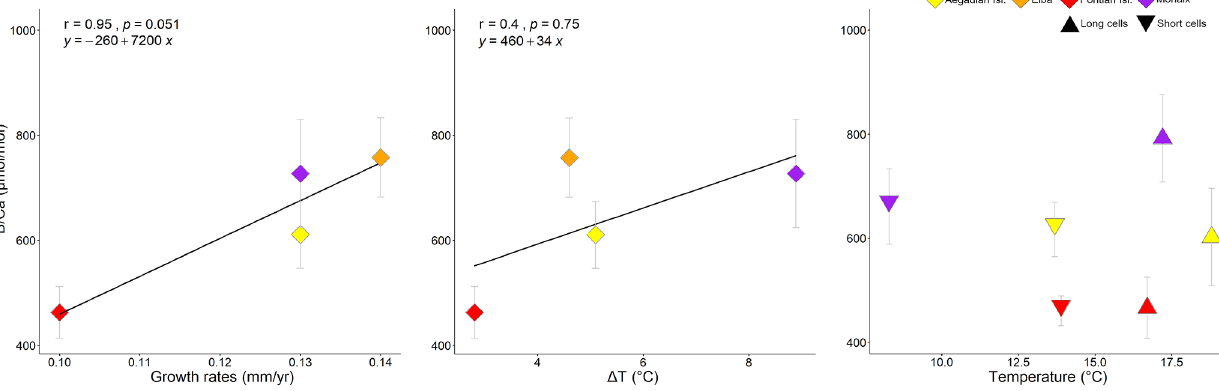
Figure 11. Correlation plots of growth rates and seawater temperature with B / Ca in L. corallioides samples analysed in this study. Spearman’s coefficient r , the p value, and the line equation are given. Temperature variations ( (cid:49)T ) correspond to the differences between the maximum and minimum temperature registered over 11 years of monthly reanalysis (ORAS5). The B / Ca means measured in long and short cells respectively correspond to the maximum and minimum